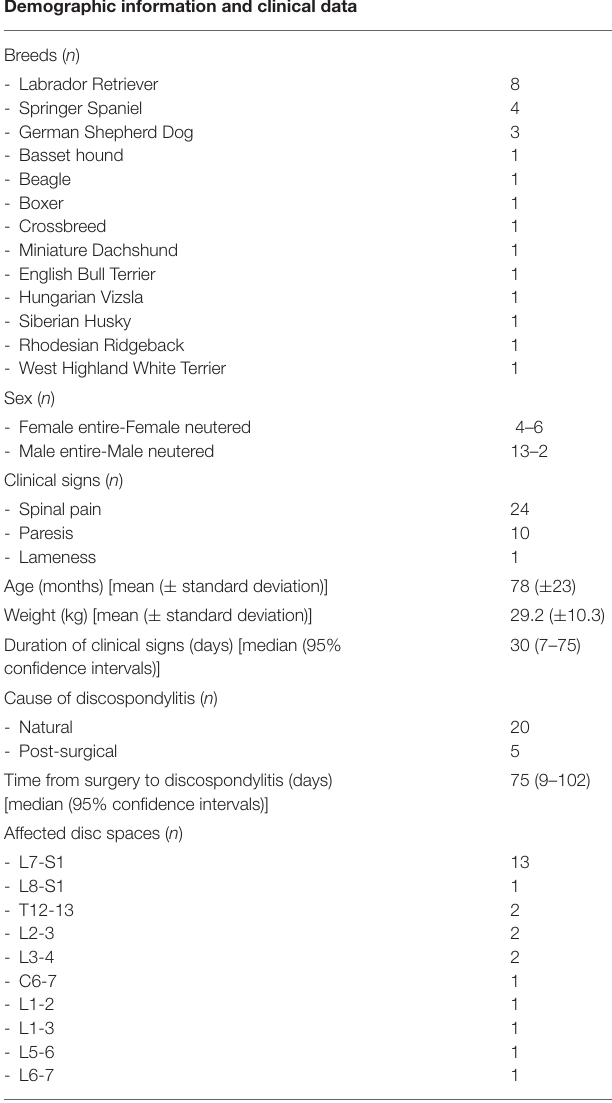
TABLE 1 | Demographic information and clinical data of 25 dogs with discospondylitis included in this study. Demographic information and clinical